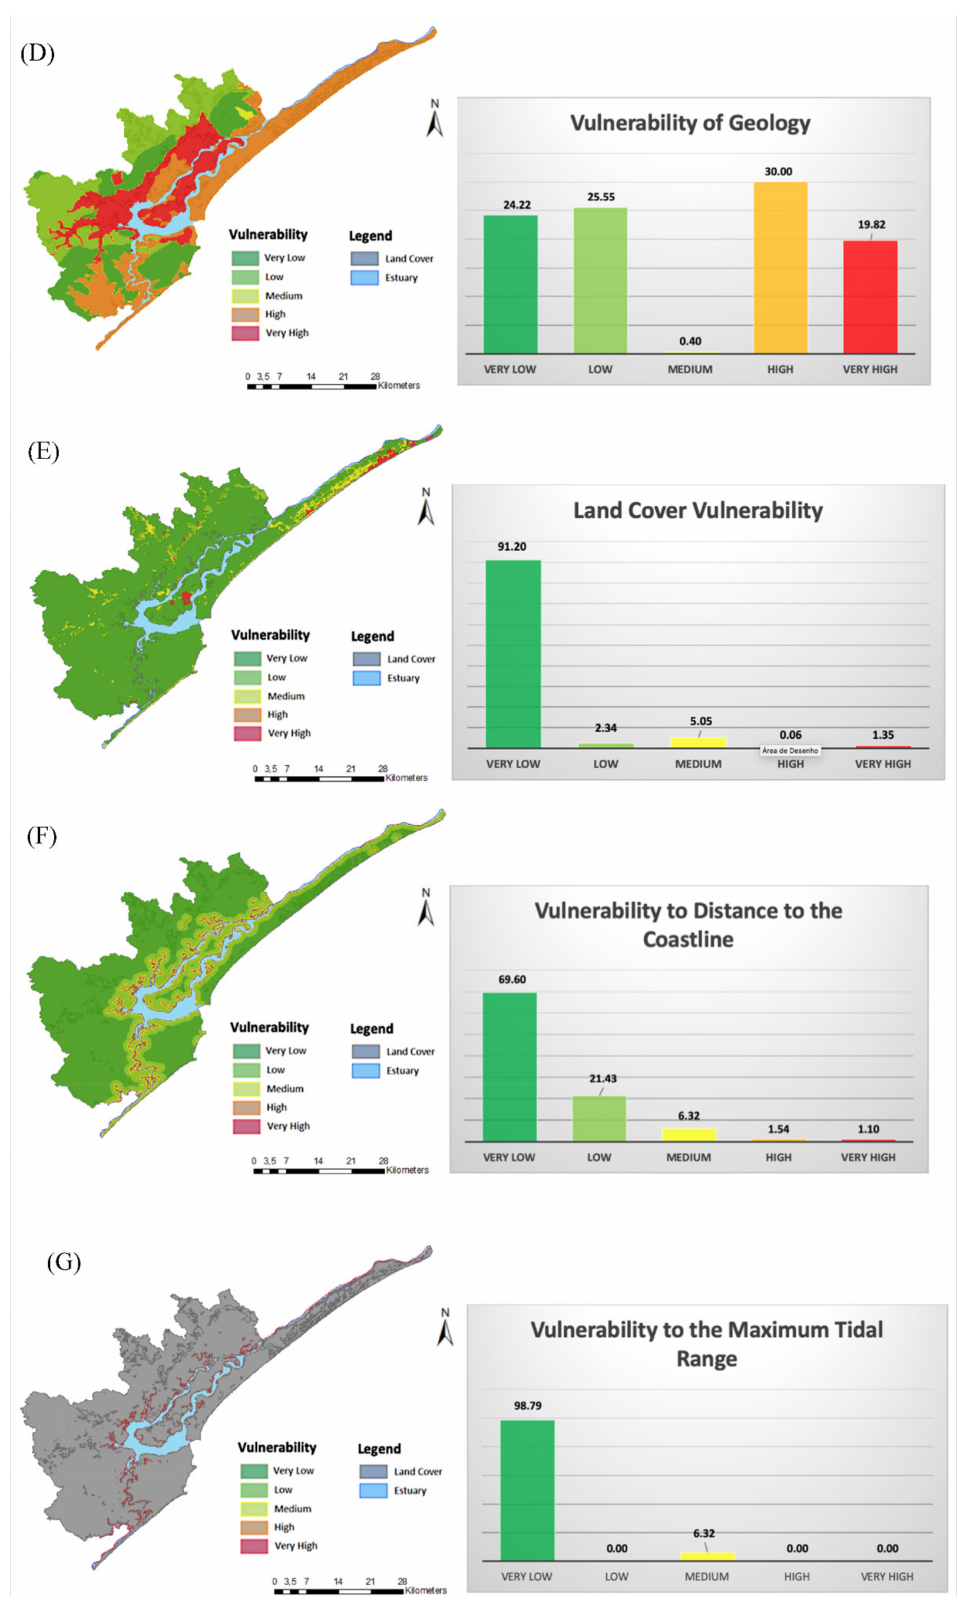
Figure 2. Modelled vulnerability for ( A ) anthropogenic activities, ( B ) elevation, ( C ) geomorphology, ( D ) geology, ( E ) land cover, ( F ) distance to the coastline and ( G ) maximum tidal range. The vulnerability levels associated with each area as well as its corresponding percentage (in the integrated graphic) are also